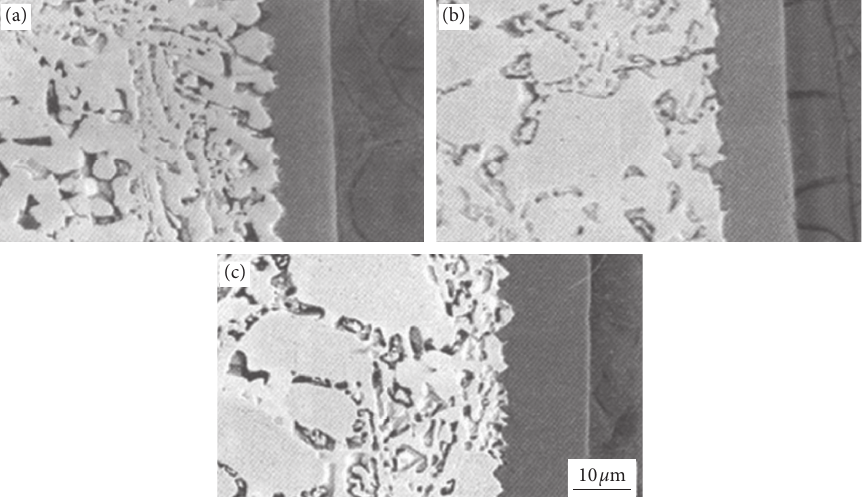
Figure 13: Cross-sectional electron images of Au-Ag-Si/Ni solder joint at different soldering temperatures: (a) 510 ° C, (b) 530 ° C, and (c) 550 ° C [69].